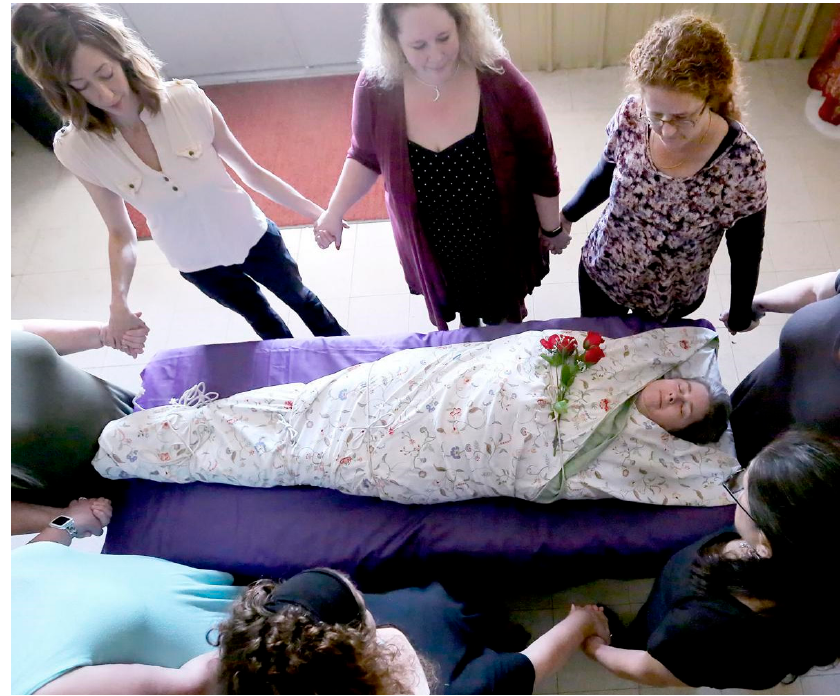
Figure 1. Women undertaking death doula training in Madison, USA, practice a ceremony for shrouding and sending of the spirit of the deceased.